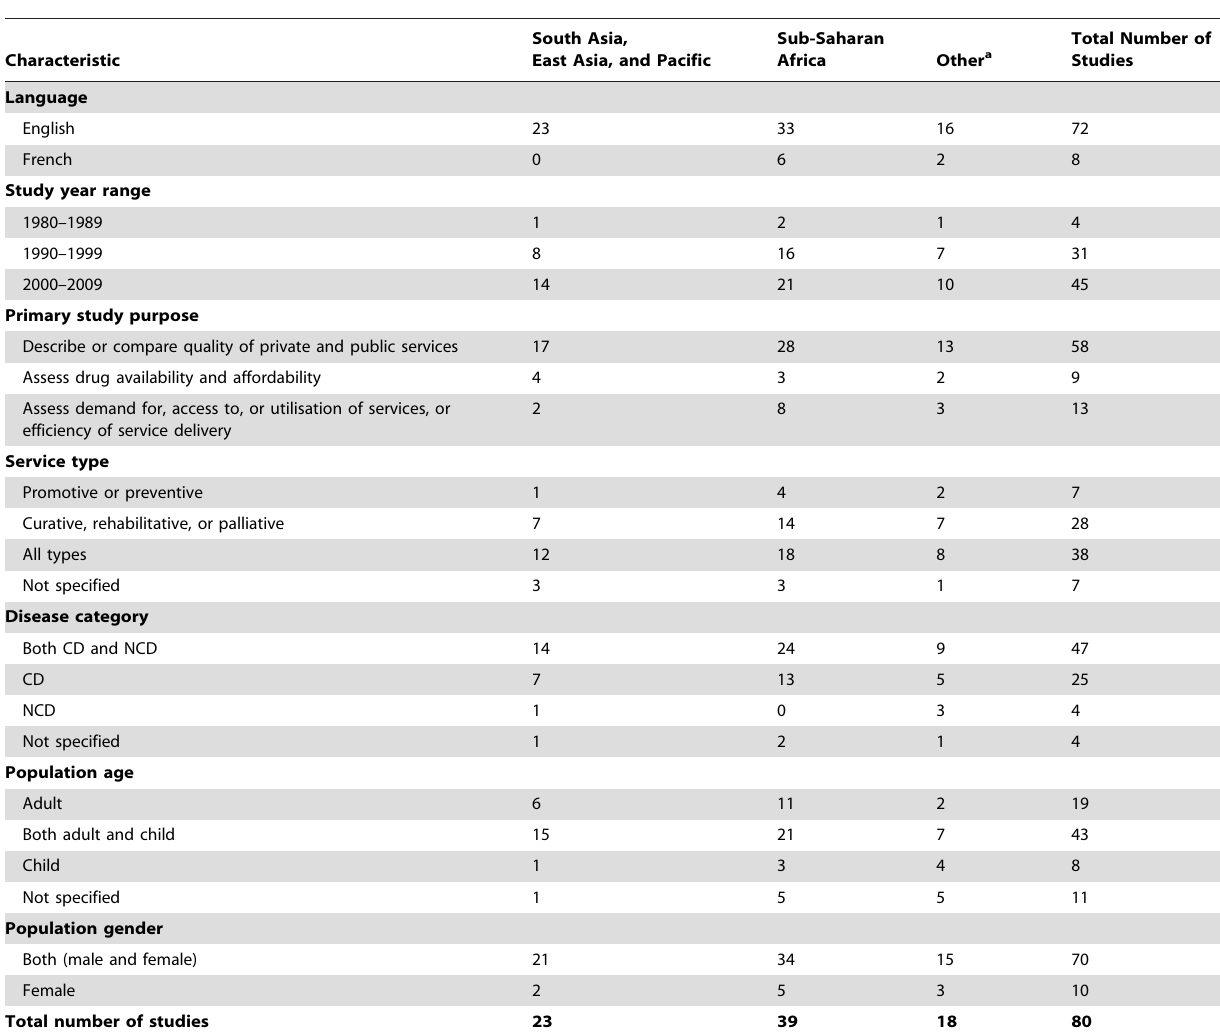
Table 2. Characteristics of quantitative studies comparing public and formal private providers by region ( n =